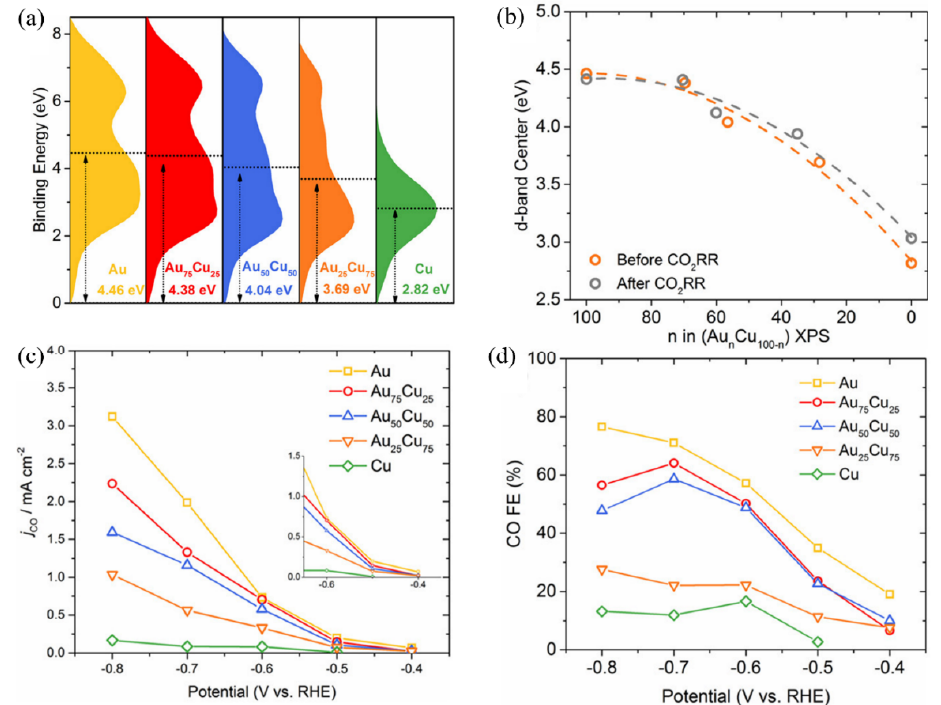
Figure 2. ( a ) Surface valence band X-ray photoemission spectra of the as-prepared Au, Cu and Au–Cu alloys. ( b ) d -band center of different samples before and after ECR at − 0.7 V vs. RHE for 1 h. The gravity center of the valance band center is shown by the dotted lines compared to 0 eV. The binding energy is the value of | E − E Fermi | . ( c ) Faradaic efficiency of and ( d ) partial current densities of CO. Reprinted from [117], Copyright (2018), with permission from American Chemical Society.